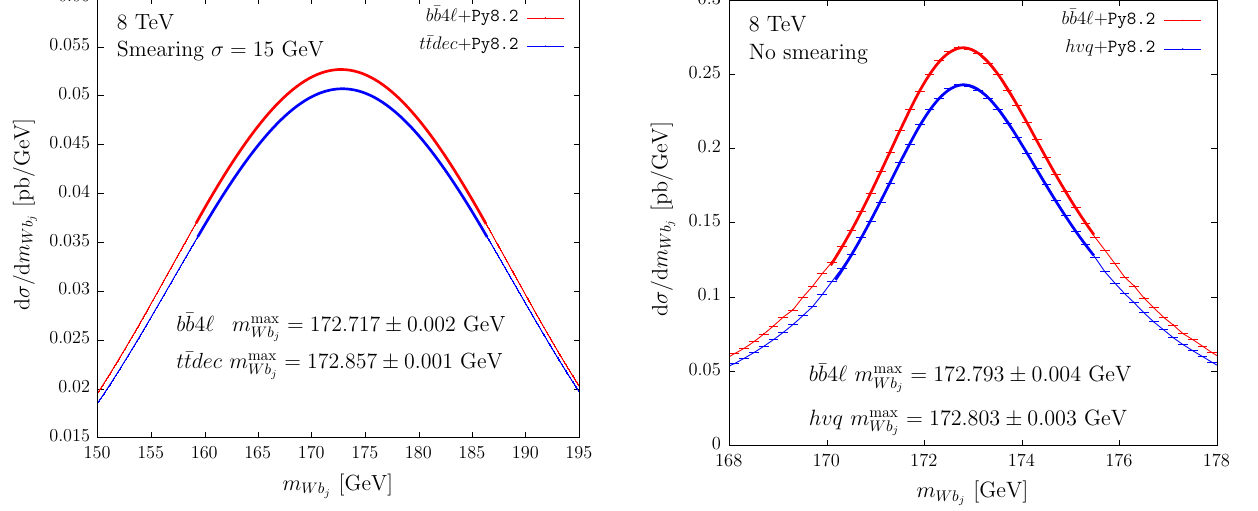
Fig. 10 d σ/ dm Wb distribution obtained with the b ¯ b 4 (cid:4) and h v q gen- j erators interfaced with Pythia8.2 , for m t = 172 . 5 GeV